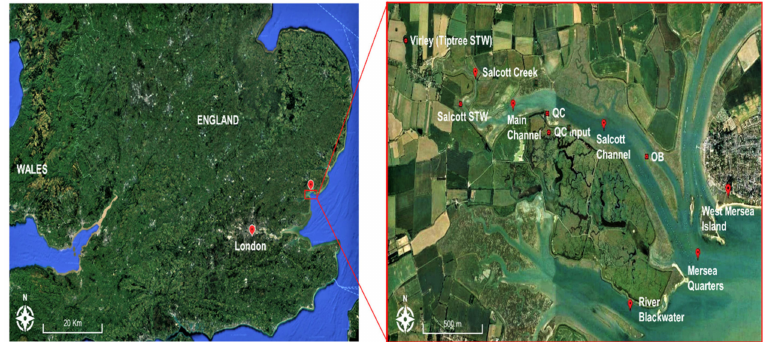
Figure 1. Mapofthestudysite, SalcottCreekChannel, Essex,